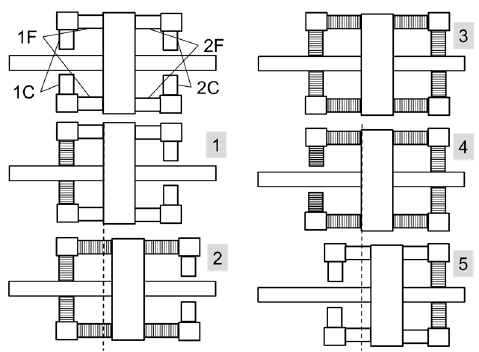
Figure 2. Motion sequences of a piezo-walk-drive motor proposed by Shamoto in 1993 [22].